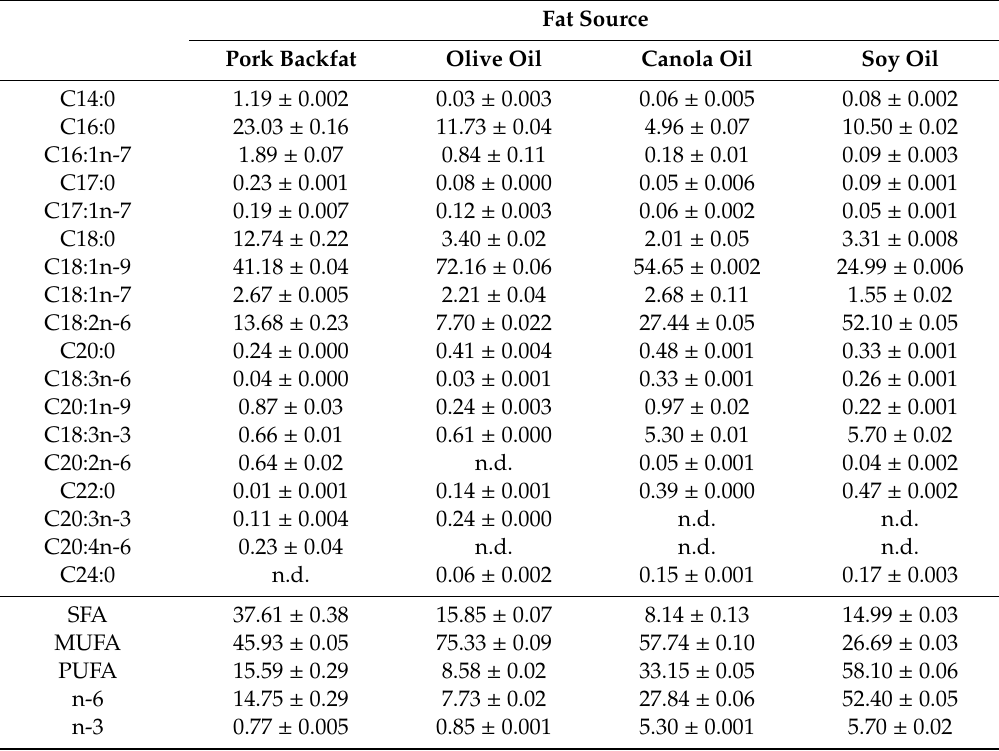
Table 1. Fatty acid composition (expressed as g / 100 g of total fatty acids) of fat sources. Fat Source Pork Backfat Olive